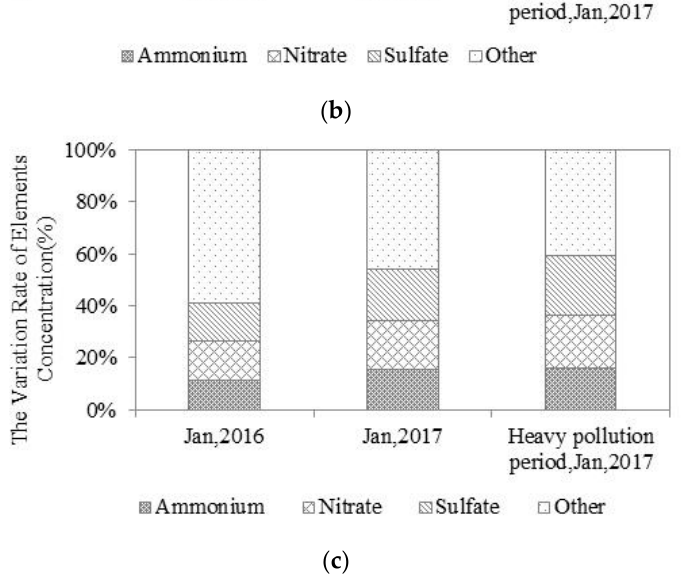
Figure 8. Mass percentages of chemicals in PM 2.5 in ( a ) Beijing, ( b ) Tangshan, ( c ) Shijiazhuang.